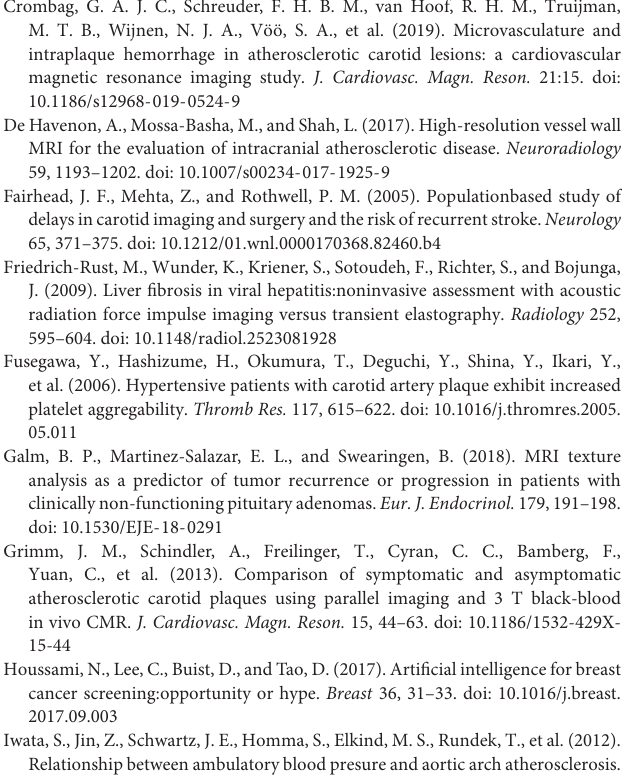
Supplementary Figure 1 | Corresponding multi-contrast magnetic resonance (MR) images of two typical carotid plaques in the lateral imaging view. (A,E) HRMRI T1WI images. (B,F) HRMRI T1WI C + images. (C,G) HRMRI T2WI images. (D,H) HRMRI PDWI images. The first plaque (first row, A–D ) was obtained from the distal segment of the left common carotid artery extending to the anterior wall of the internal carotid artery of a 62-year-old patient. The presence of moderate enhancement, defined as neovascularization or inflammation in the T1WI C + (indicated by the white arrow) and the lipid necrotic core in the T2WI (indicated by the white arrow), indicates the plaque is more likely to be vulnerable; The second plaque (E–H) was acquired from the posterior wall of left internal carotid artery of a 70-year-old patient. The fibrillar component is observed as the high-intensity area in the T2WI and PDWI (indicated by the white arrow); the high risk composition was absent, indicating the stability of this plaque. Supplementary Figure 2 | (A) The calibration curve of the nomogram model. Apparent represents the original curve, Ideal represents the reference line obtained by the ideal model, and Bias-corrected represents the calibration curve. The ideal curves and calibration curves were very close in the testing set. (B) DCA curve for the nomogram. The net benefit was plotted vs. the threshold probability. The dotted line represents the nomogram. The gray and black lines represent the treat-all-patients scheme or the treat-none scheme, respectively. DCA, decision curve